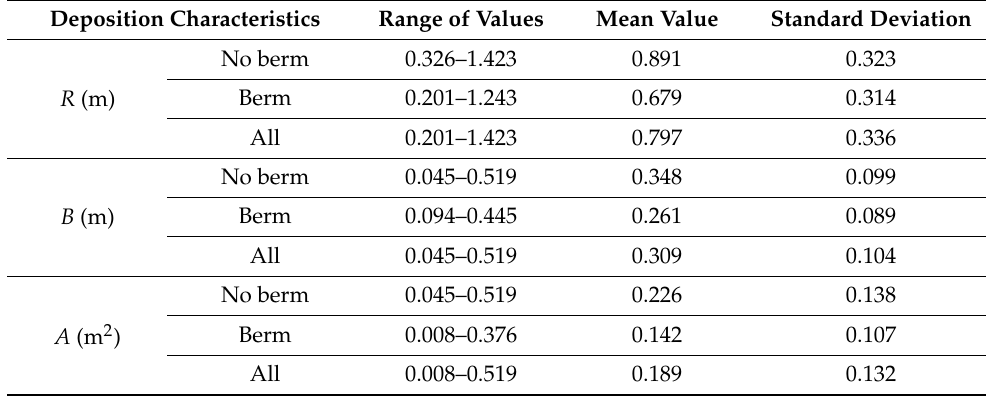
Table 4. Deposition characteristics of debris